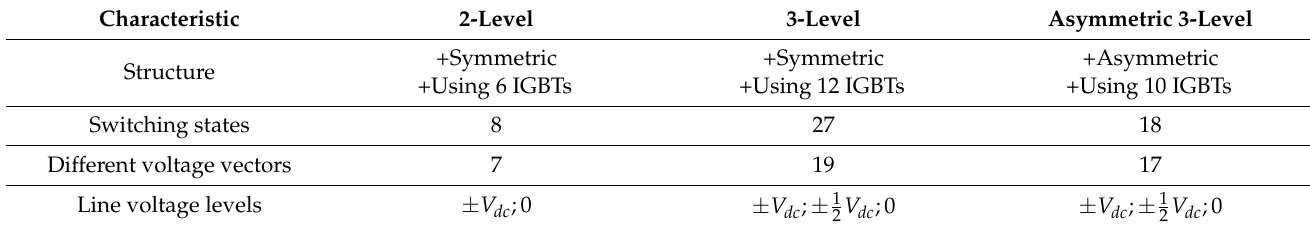
Table 3. Typical properties comparison of conventional 2-level, 3-level, and asymmetric 3-level inverter.